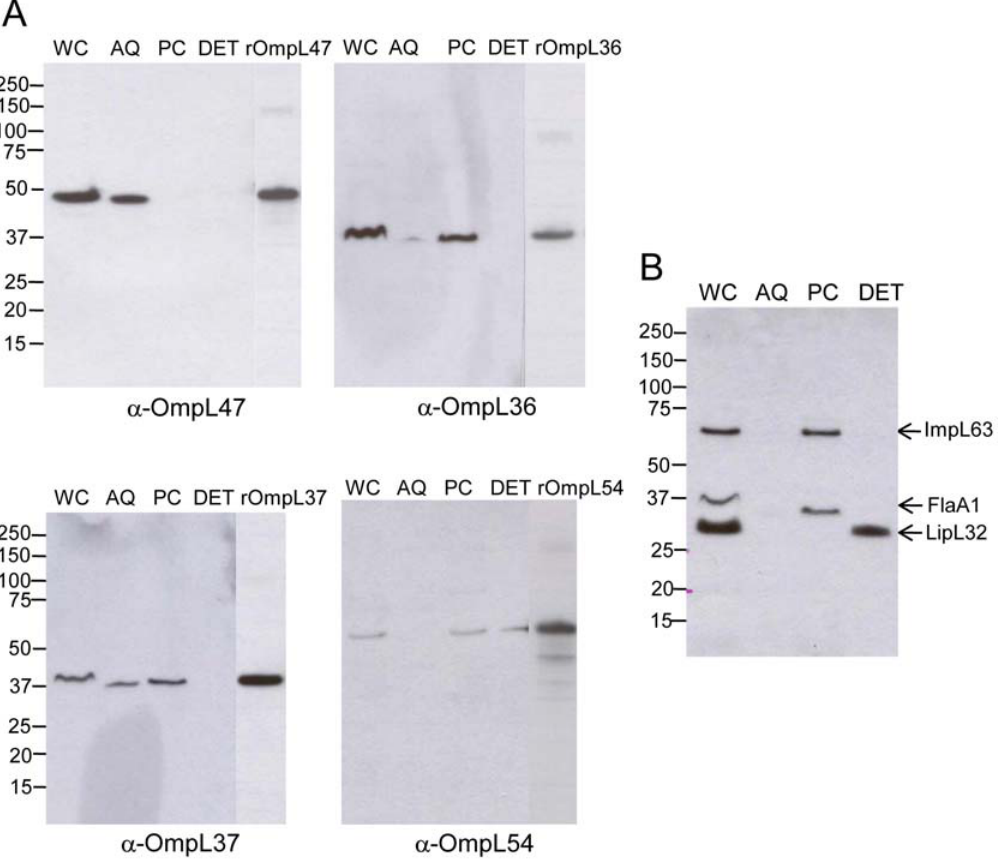
Figure 1. Localization of OmpL36, OmpL37, OmpL47 and OmpL54 after detergent fractionation of L.interrogans Fiocruz L1–130. Equivalents of 1 6 10 8 of leptospires per lane or 0.5 m g of recombinant proteins per lane are separated on gel electrophoresis (Bis-Tris 4–12% NuPage gel, Novex), blotted to PVDF membrane and probed with rabbit immune sera. L. interrogans serovar Copenhageni strain Fiocruz L1–130 whole cell lysate (lane WC), the aqueous fraction (lane AQ), the protoplasmic cylinder fraction (lane PC) and the detergent fraction (lane DET). rOmpL36, rOmpL37, rOmpL47, and rOmpL54 denote the corresponding recombinant proteins. (A) Membranes probed with OmpL36, OmpL37, OmpL47 and OmpL54 antisera. (B) Membrane probed with ImpL63, FlaA1 and LipL32 antisera. The identities of individual proteins are indicated on the right, and the positions of molecular mass standard (in kilodaltons) are indicated on the left.